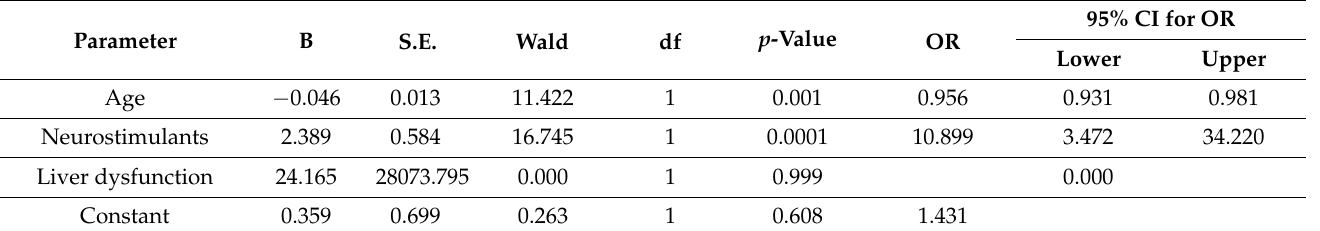
Table 2. Multivariate